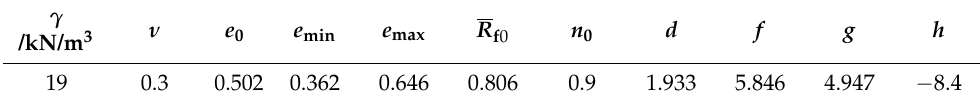
Table 10. Computing parameters of soil for constitutive model considering disturbance.